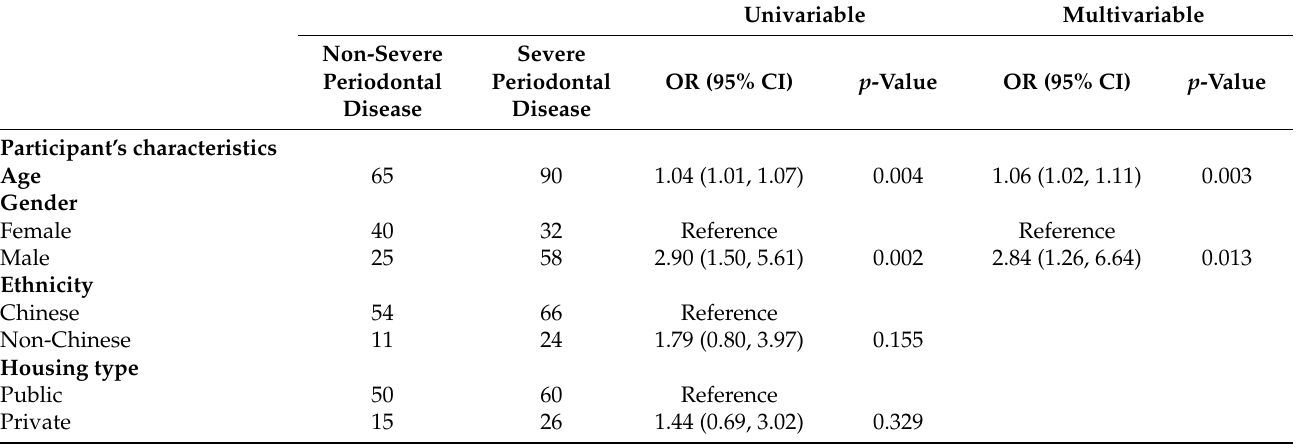
Table 3. Association of self-reported questions on severe periodontitis according to WWC classifica- tions by logistic